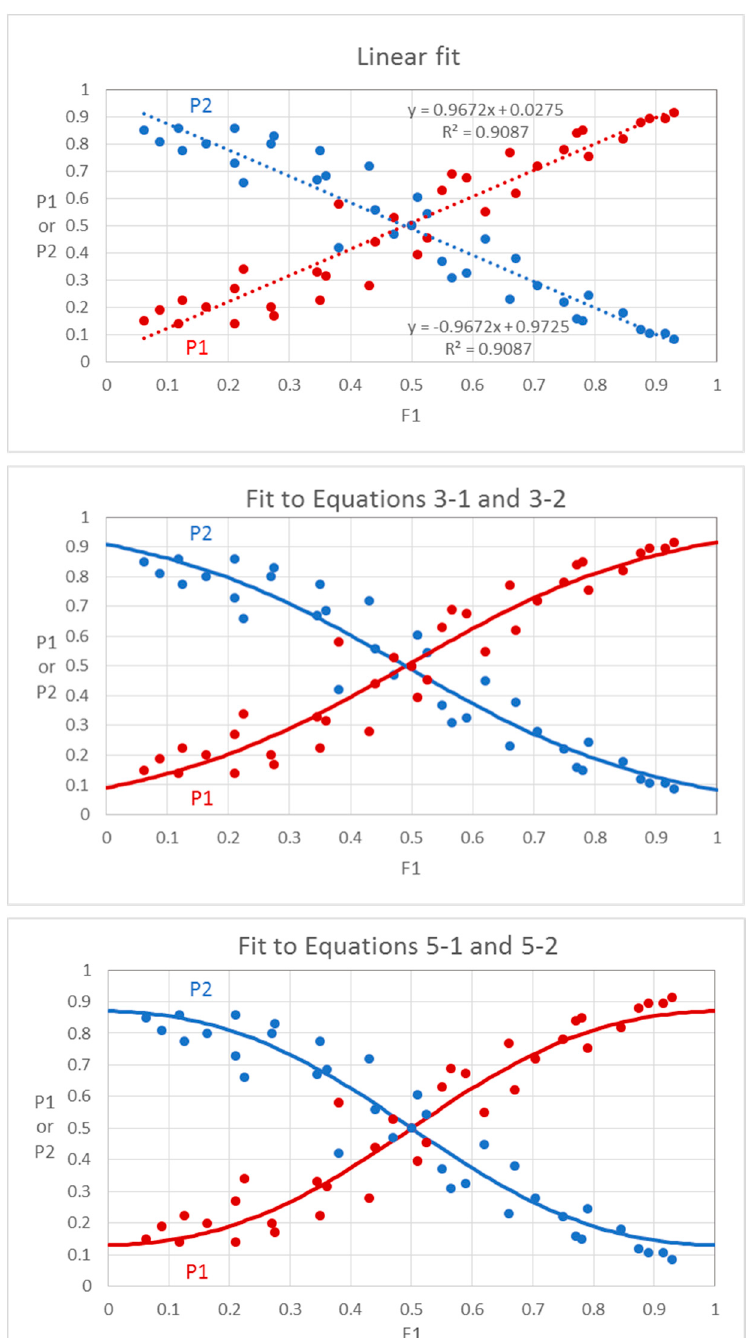
Figure 9. Probability of identification of components in eugenol-propionic acid mixtures. Data extracted from Figure 2a of Ferreira [16]. P1 is the probability of identification of eugenol (red points), P2 is the probability of identification of propionic acid (blue points), and F1 is the fractional intensity of eugenol in the mixture. The top graph shows fit to straight line, the middle graph shows fit to Ferreira model, and the bottom graph shows fit to Hettinger and Frank model. The fits of both models are equally good, and better than the linear fit. Details of fitting of models can be found in Supplementary Material. Extracted from [16] with permission from Wiley.